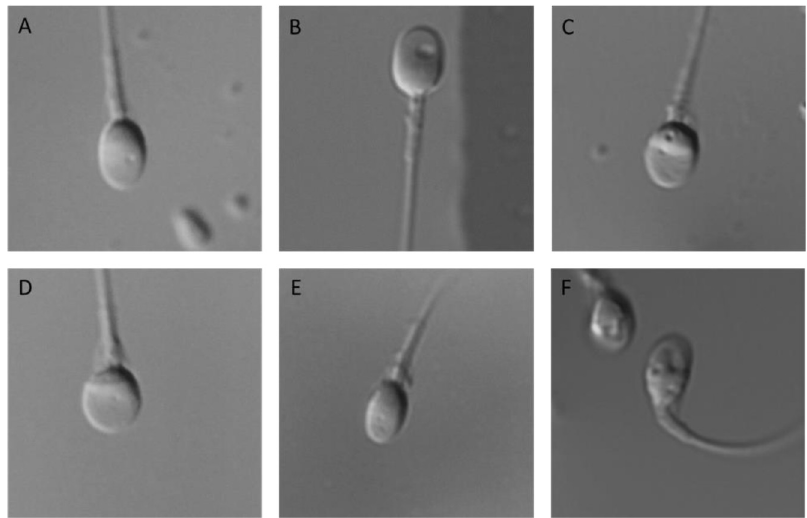
Fig 1. Sperm head morphology at 6000x magnification. A. Normal morphology. B. Large acrosomal vacuole. C. Equatorial and post-acrosomal vacuoles. D. Wide head. E. Narrow head. F. Highly vacuolated head.